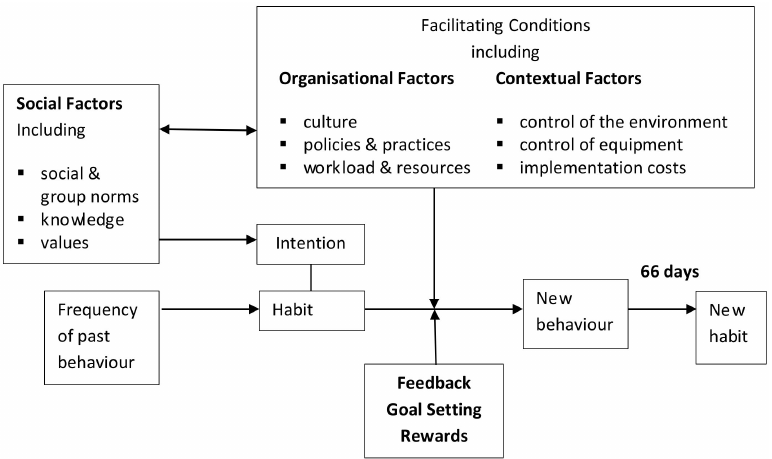
Figure 1. Model of the behavior change approach used in a NHS community hospital adapted from a revised version of Triandis’ Theory of Interpersonal Behavior reproduced in Chatterton, 66 day training period